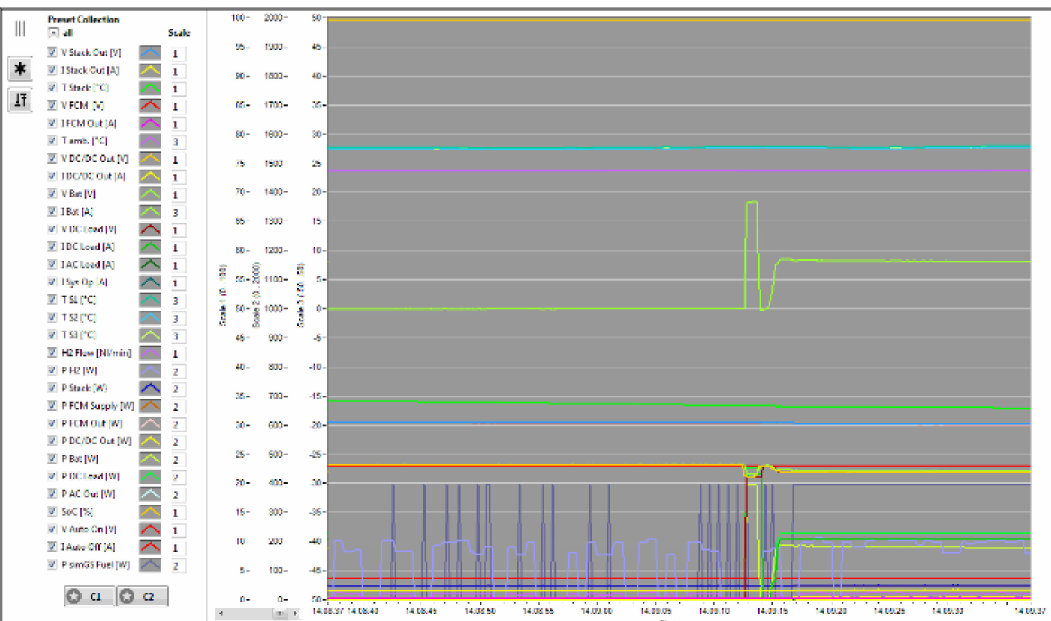
Figure 11. The Polarization Curves of the PEMFC.